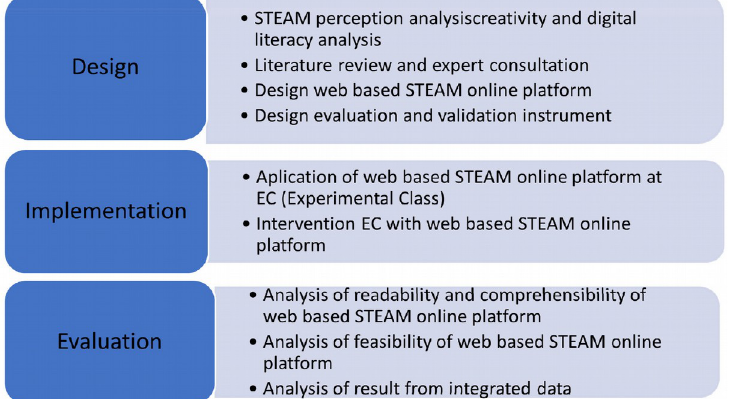
Figure 1. The Step of Development Web-based STEAM online platform